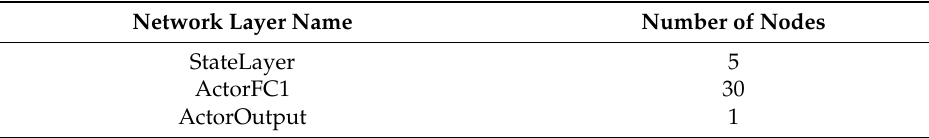
Figure 5. The diagram of policy network. Table 3. Policy network parameters.